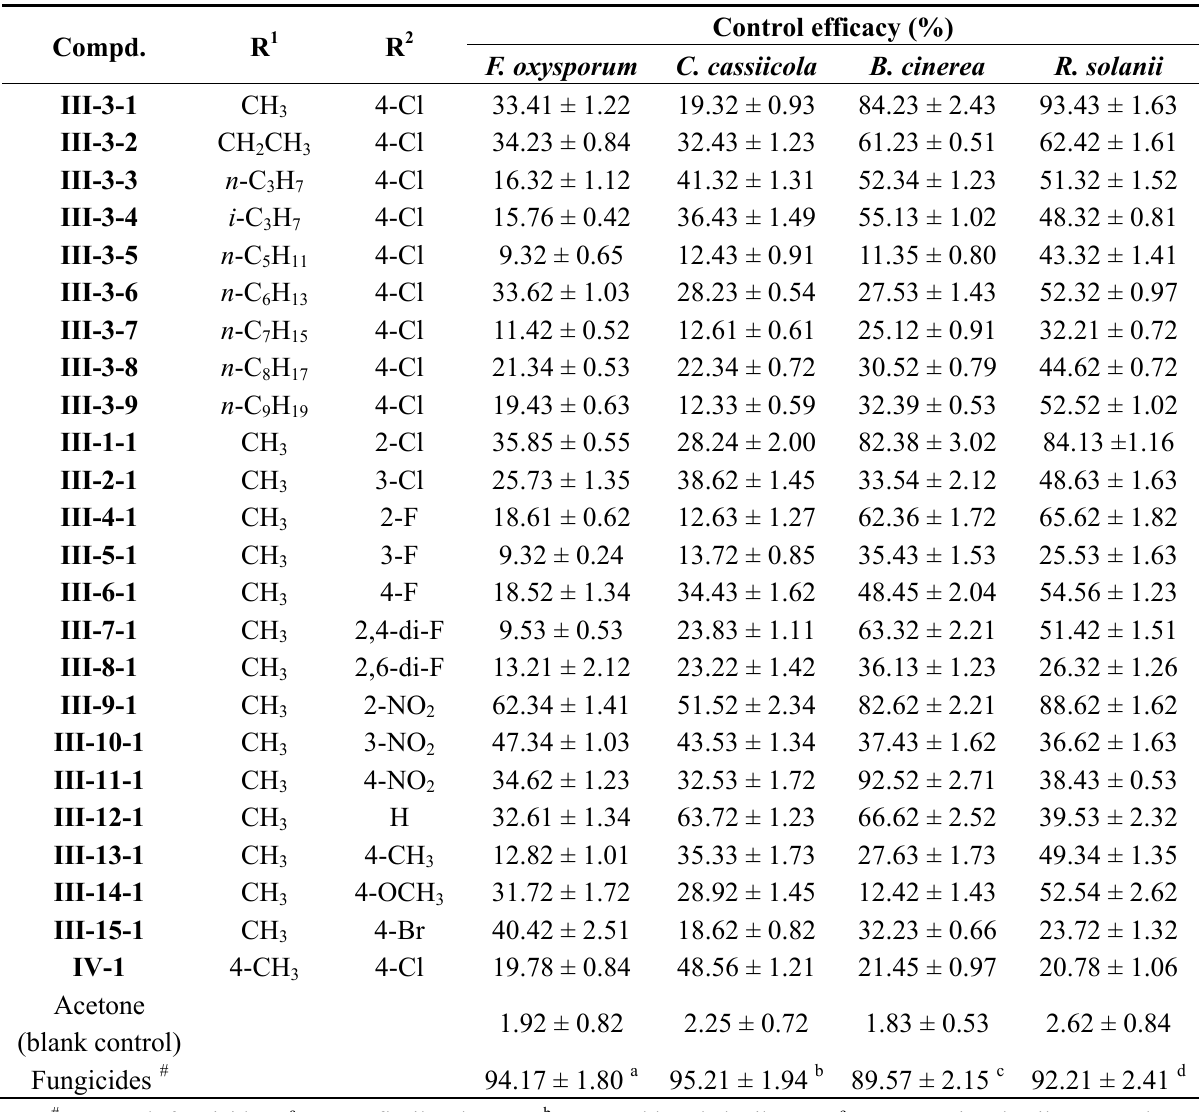
Table 5. Fungicidal activities of title compounds against four fungus species at 500 μ g·mL − 1 in vivo.